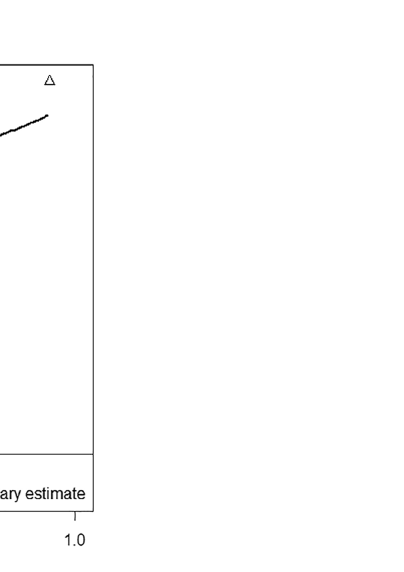
Figure 2. Coupled forest plots of the sensitivity and specificity of the age-adjusted quick Sequential Organ Failure Assessment score for predicting mortality and disease severity in pediatric patients with suspected or confirmed infection.